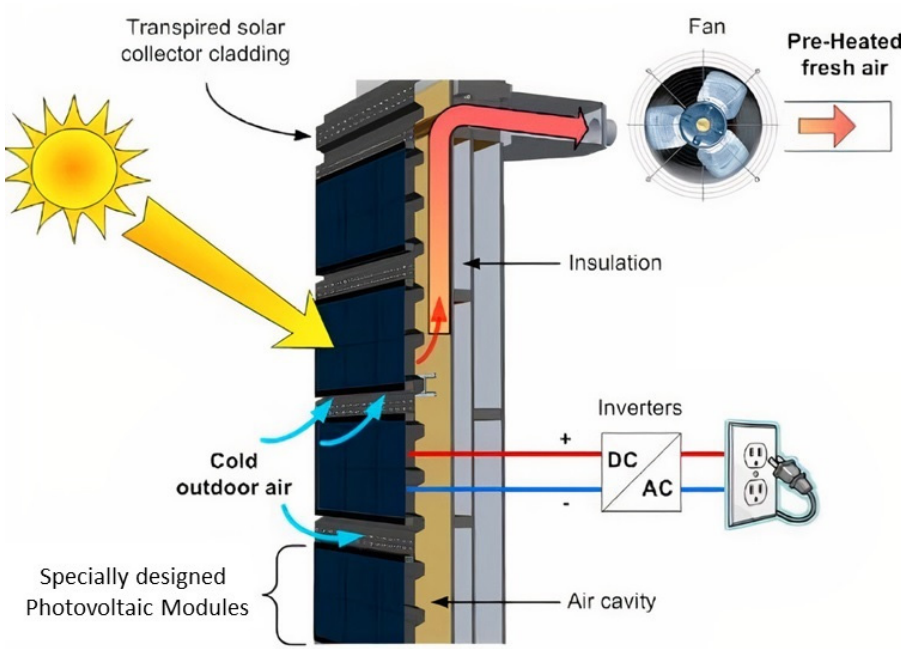
Figure 8. Schematic for BIPV/T system [51].